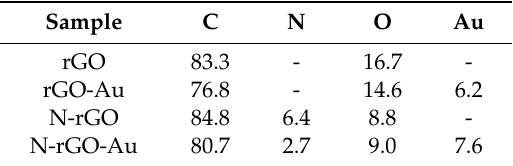
Table 1. Surface chemical composition of rGO, N-rGO, and their nanocomposites with AuNPs determined by XPS (at.%).